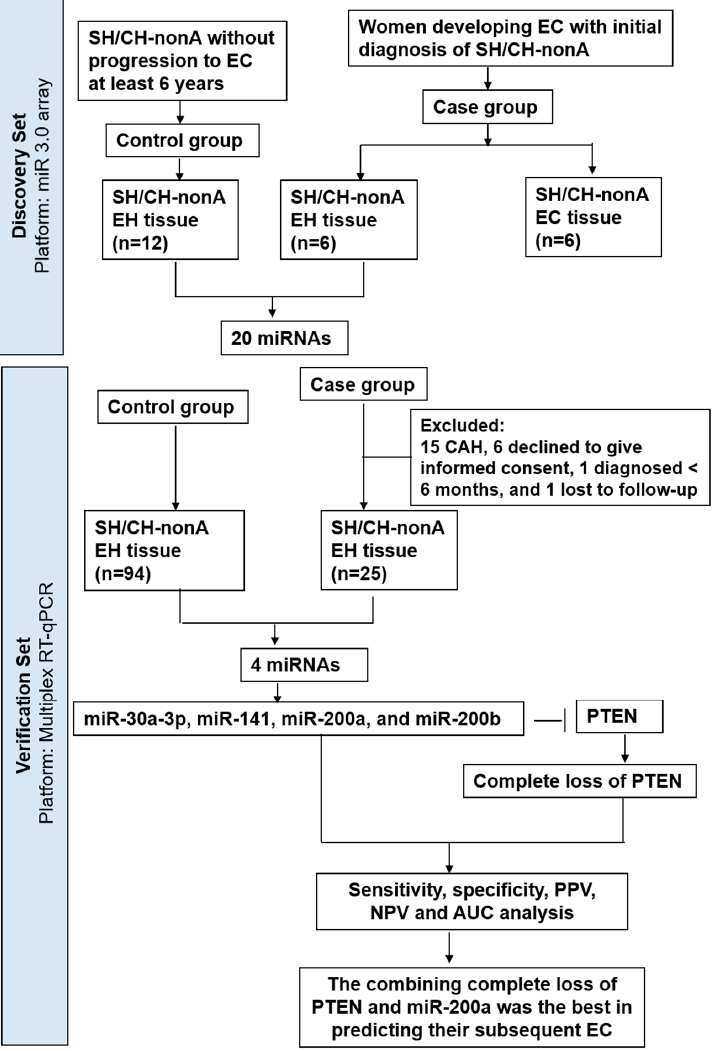
Figure 5. Study profile. During the discovery phase, miRNA array analyses revealed that 20 miRNAs differed significantly ( p < 0.05, fold change >4) between the control ( n = 12) and case ( n = 6) patients. During the validation phase, multiplex RT-qPCR revealed that, among the 20 miRNAs, miR-30a-3p, miR-141, miR-200a, and miR-200b were significantly different ( p < 0.05) between the expanded control ( n = 94) and case ( n = 25) cohorts. Sensitivity, specificity, PPV, NPV, and AUC analyses were performed to evaluate the performance of the four miRNAs in combination with miRNA-targeted complete PTEN loss for predicting EC risk among patients with